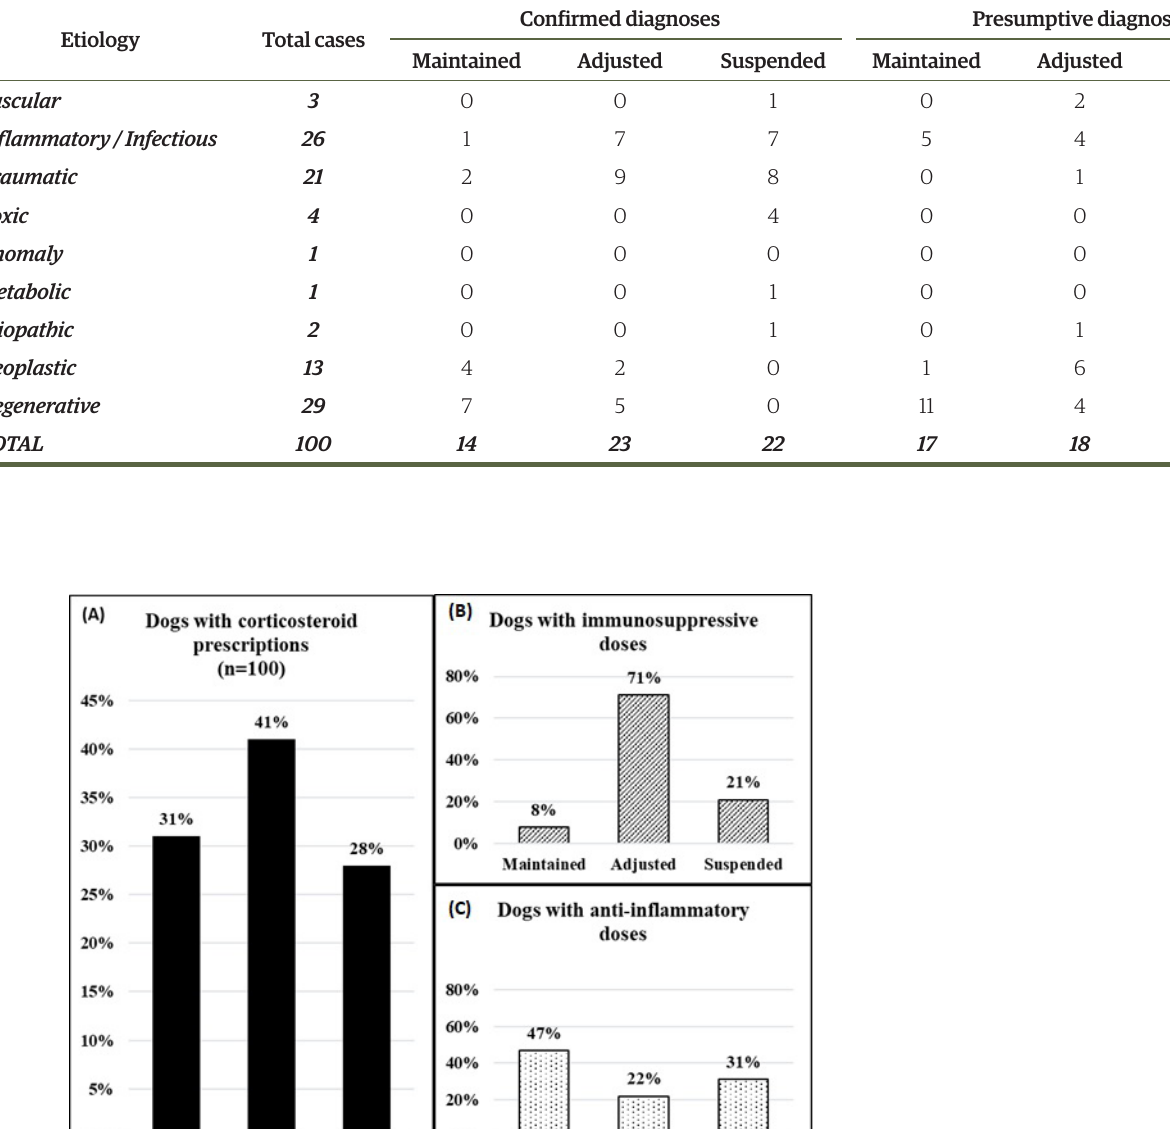
Corticosteroid use in neurology: how dogs are referrals to a neurology service?